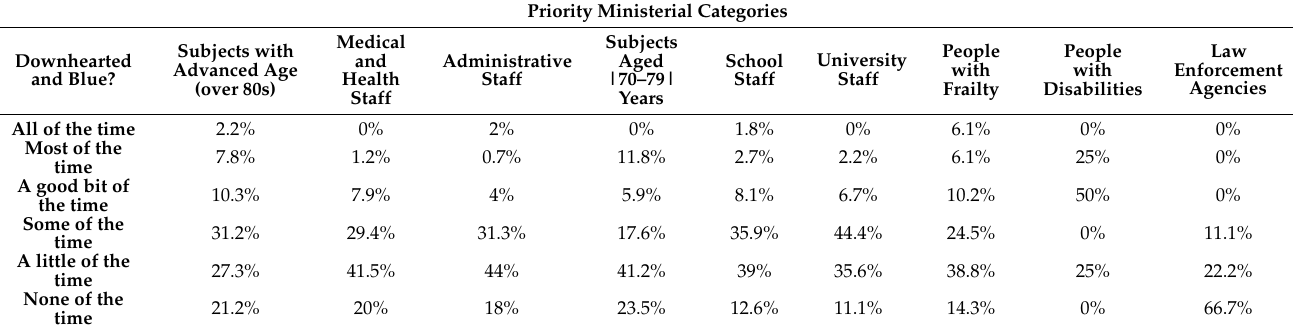
Table 5. Percentage of response frequencies related to item #11 of the SF-12 divided by priority ministerial category. Priority Ministerial